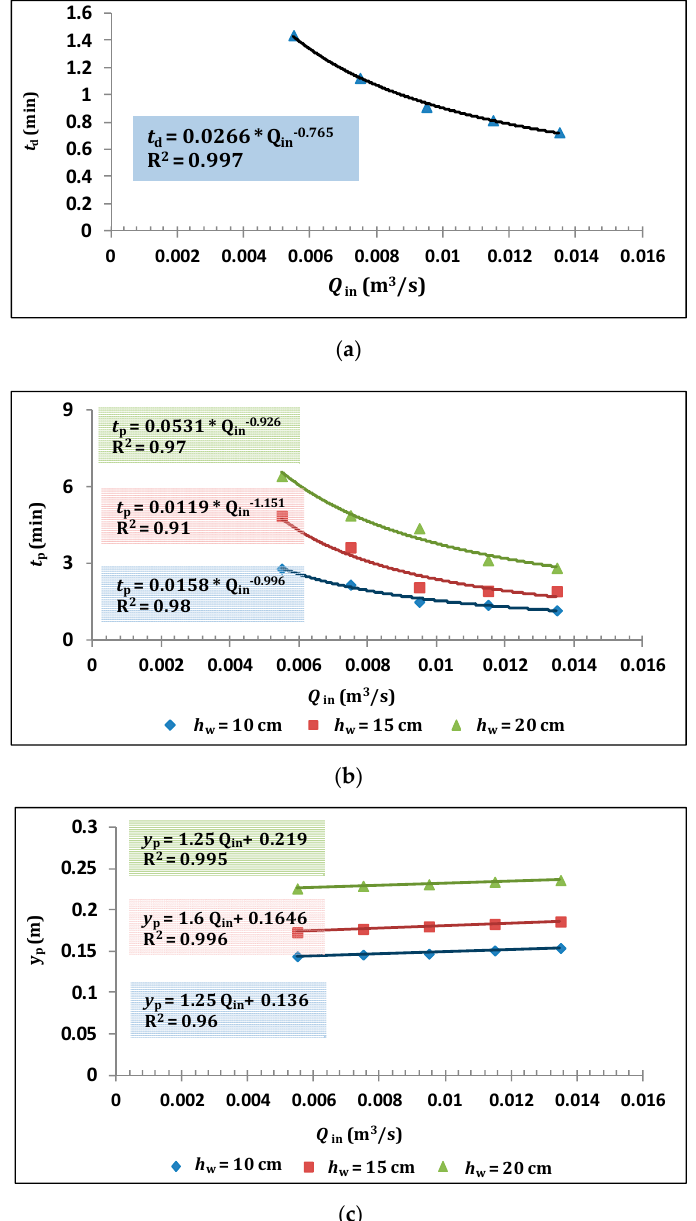
Figure 6. The experimental models developed to predict ( a ) the time to downstream t d (min), ( b ) the time to peak t p (min), and ( c ) the water level at peak flow y p (m). Table 2. The flow characteristics estimated for different experimental cases.